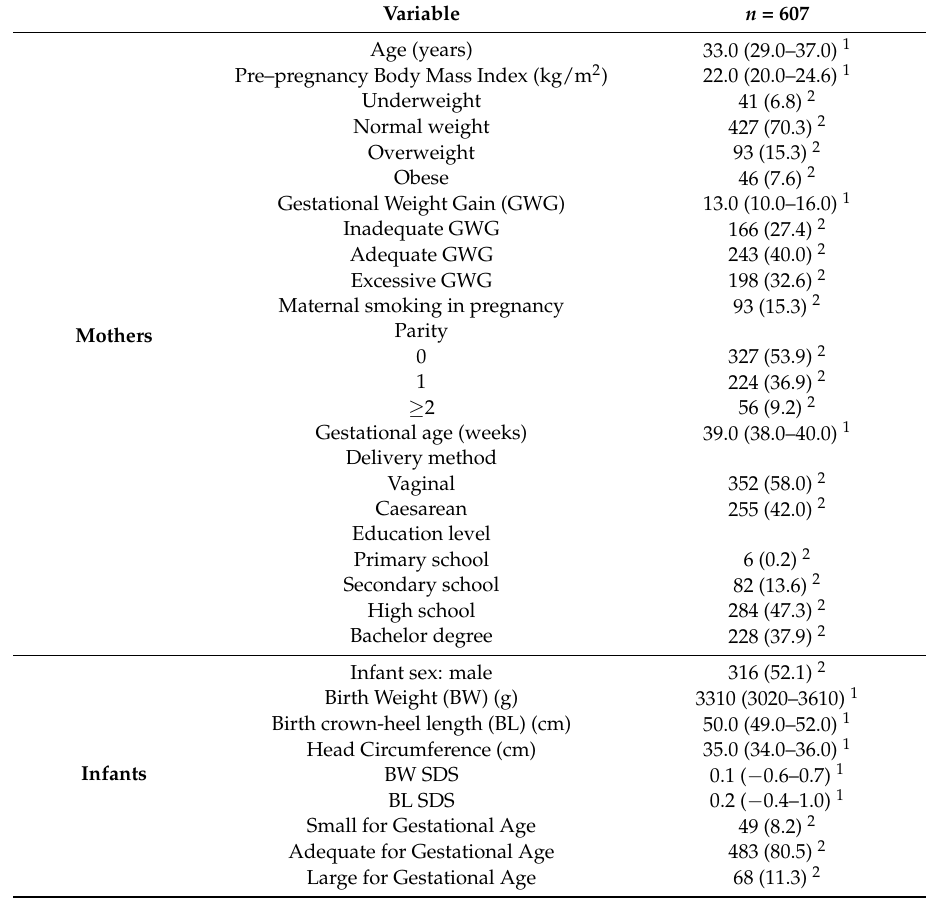
Table 1. Maternal and infant